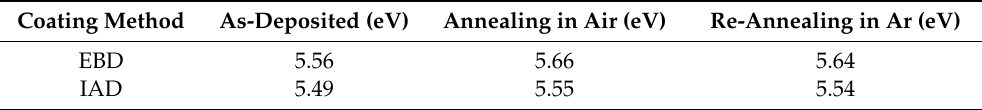
Figure 2. Tauc patterning calculated from the absorption spectra of ( a ) EBD and ( b ) IAD thin films. Table 1. The optical bandgap E g of the HfO 2 films.